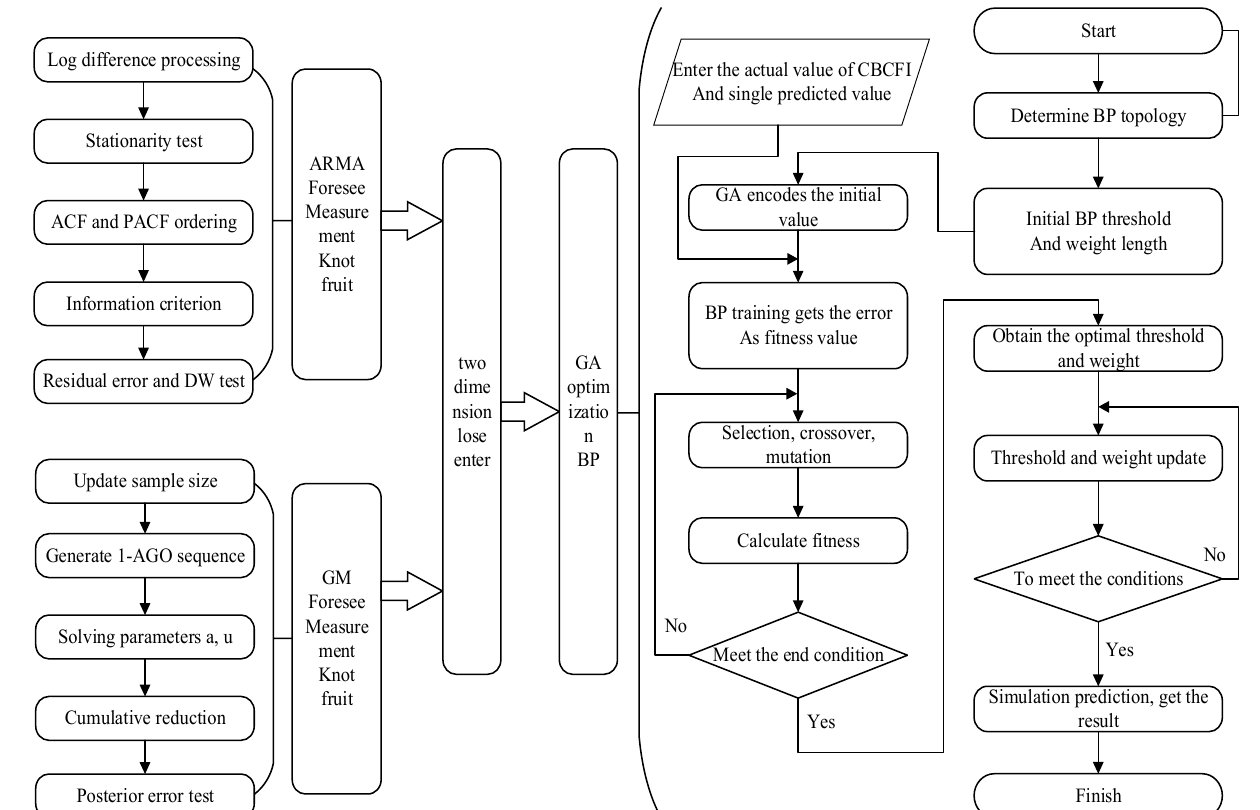
Figure 1. Structure of the ARMA-GM-GABP combined model.